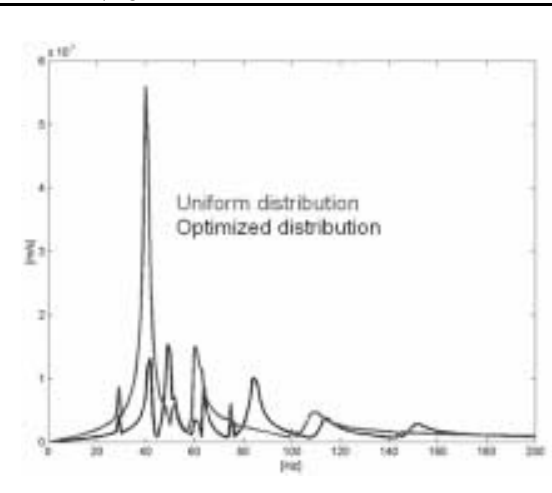
Fig. 9. Average velocity